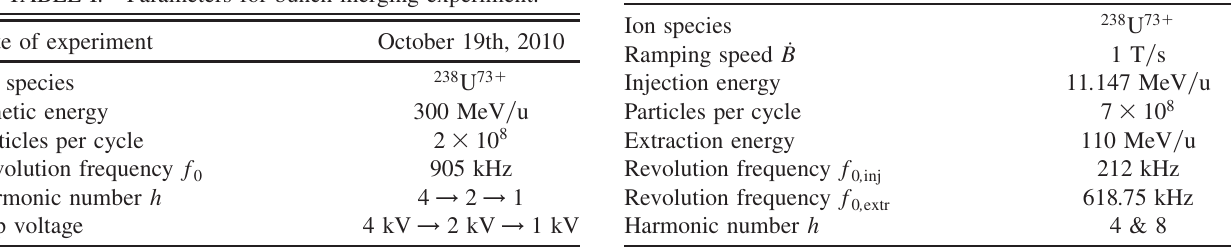
TABLE I. Parameters for bunch merging experiment.